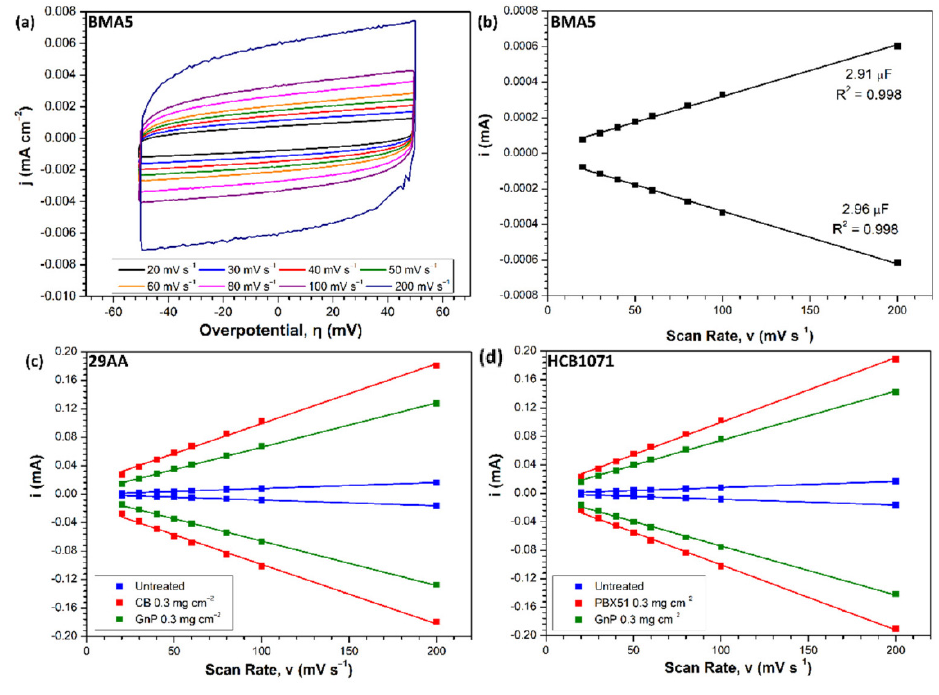
Figure 4. ( a ) Cyclic voltammograms on BMA5 graphite/PVDF electrode ( b – d ) plots of i vs. ν ( b ) BMA5 graphite/PVDF electrode, ( c ) 29AA carbon paper, and ( d ) HCB1071 carbon cloth. Electrolyte, 1 M KCl. Temperature, 298 K.